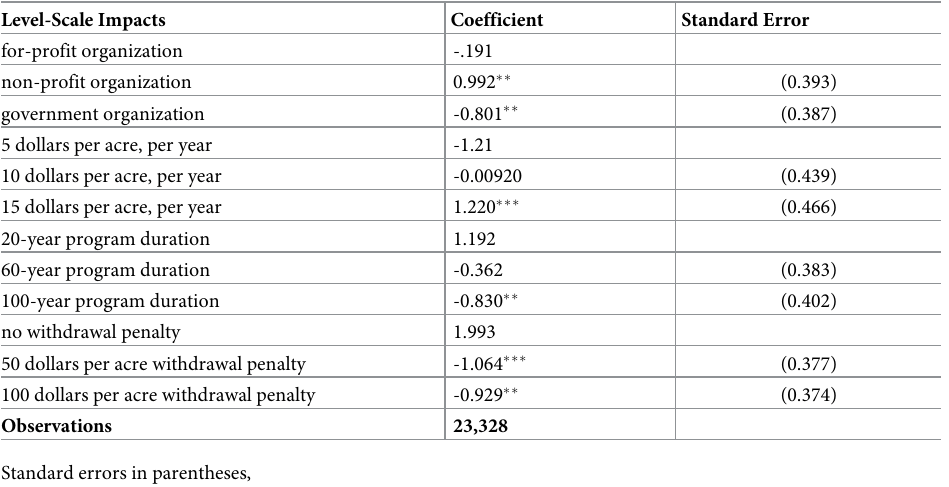
Table 4. Conditional logit level-scale